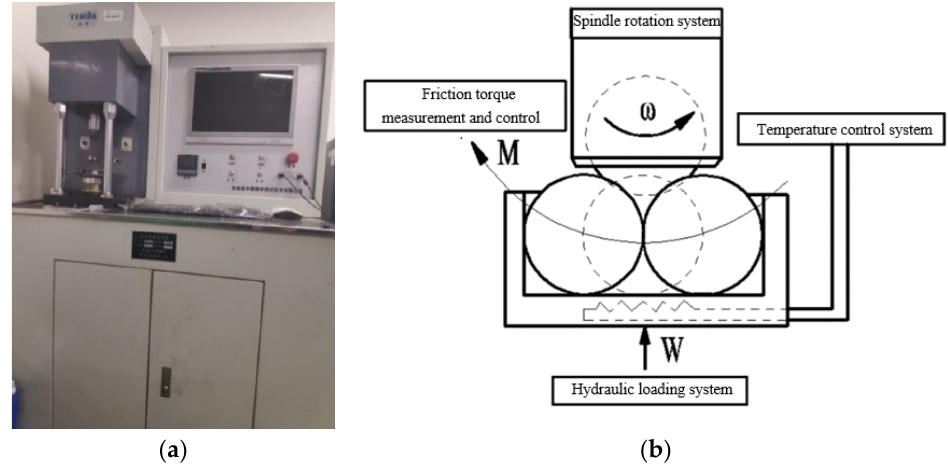
Figure 2. MRS-10A four-ball friction and wear testing machine: ( a ) picture; ( b ) schematic diagram.